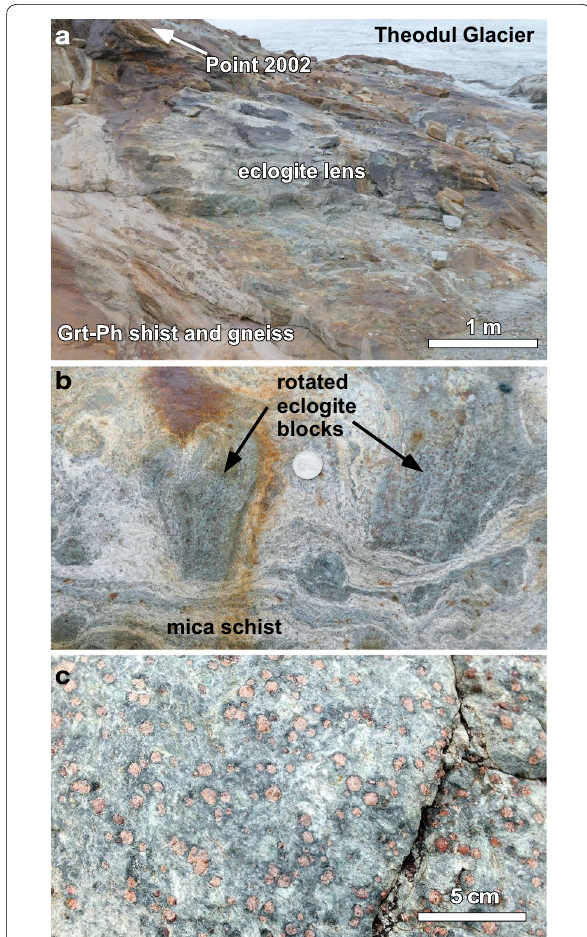
Fig. 5 Outcrops of TGU eclogites at the W-slope of point 3002 (Fig. 2). a eclogite lens within Grt-Ph schist. b Rotated blocks of banded and foliated eclogite in Grt-Ph schist matrix. c eclogite with ~ 10% modal euhedral garnet of 2–5 mm in diameter in a matrix of relic Omp, Cam, Ph, Pg, Chl, Ep, Qz, and